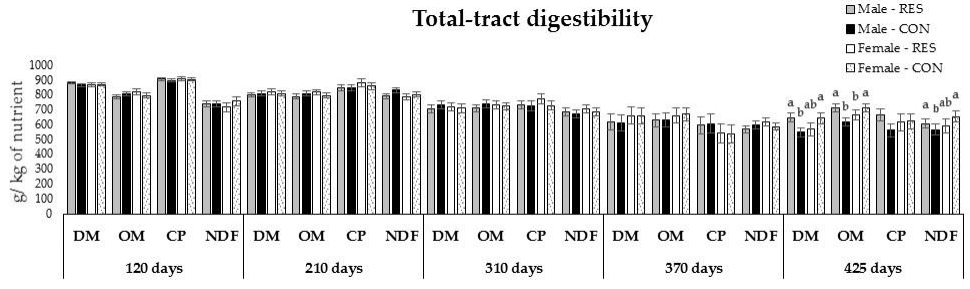
Figure 4. Dry matter (DM), organic matter (OM), crude protein (CP), and neutral detergent fiber (NDF) apparent total-tract digestibility. Bars represent mean ± SEM. a,b Significant differences between the groups ( p < 0.05).